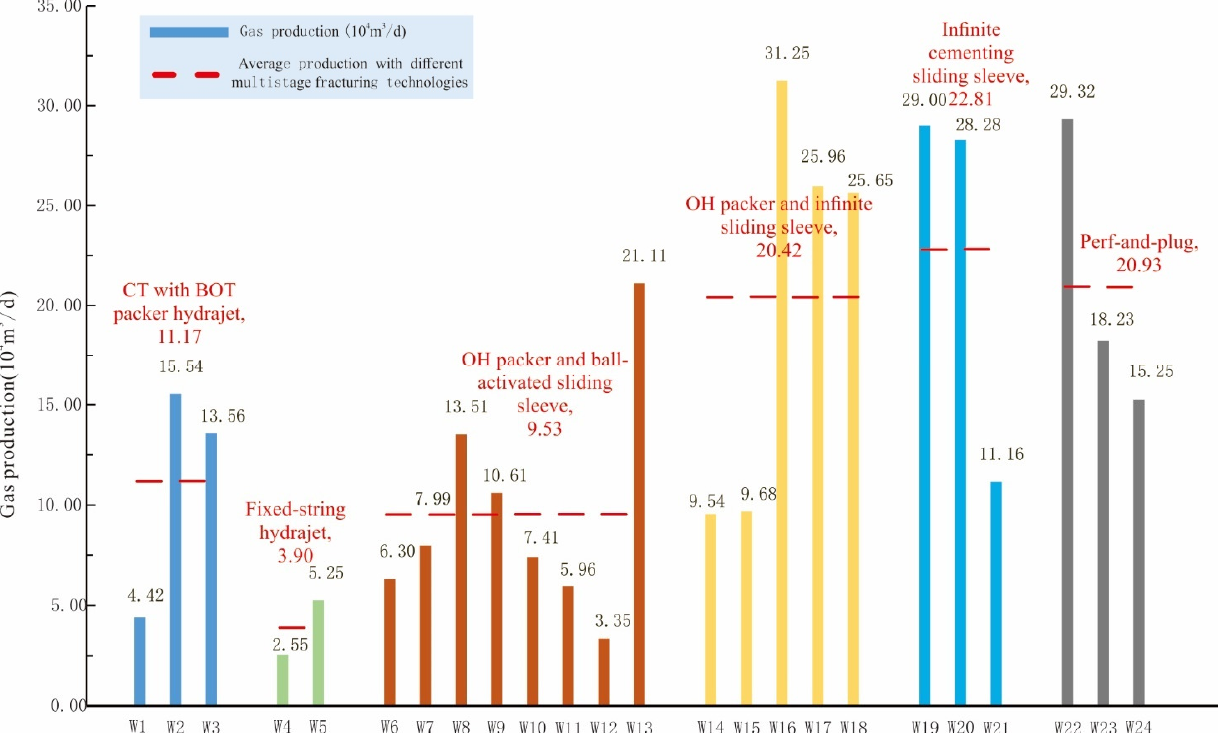
Figure 8. Production of horizontal wells with different multistage fracturing technologies.